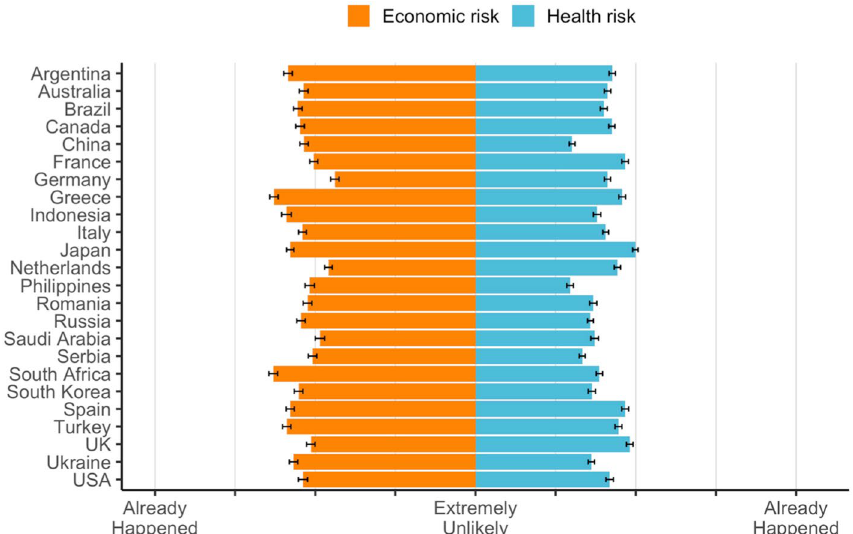
Figure 1. Perceived health risk versus perceived economic risk due to the coronavirus. Note : Raw Scores, Error Bars 95% CI. Standardized scores correcting for cross-cultural response sets returned the same country comparative hierarchy per risk. Standardized scores are presented in Supplementary Figs 1 and